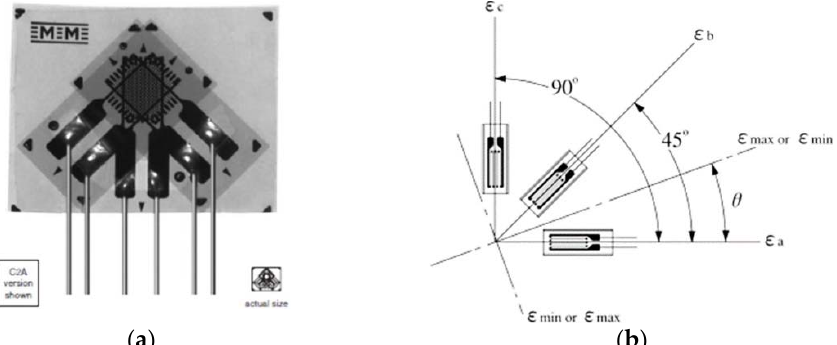
Figure 9. The transducer (rosette) of three superimposed marks, with the axes offset by 45° [Reprinted with permission from Ref. [29] Copyright 2022, General Purpose Strain Gages-Stacked Rosette. C2A ‐ 06 ‐ 062WW. Available online: https://docs.micro ‐ measurements.com/?id=2560 (Accessed 5 July 2022)], used in the present experiment ( a ); notations used in the work ( b ) [Reprinted with